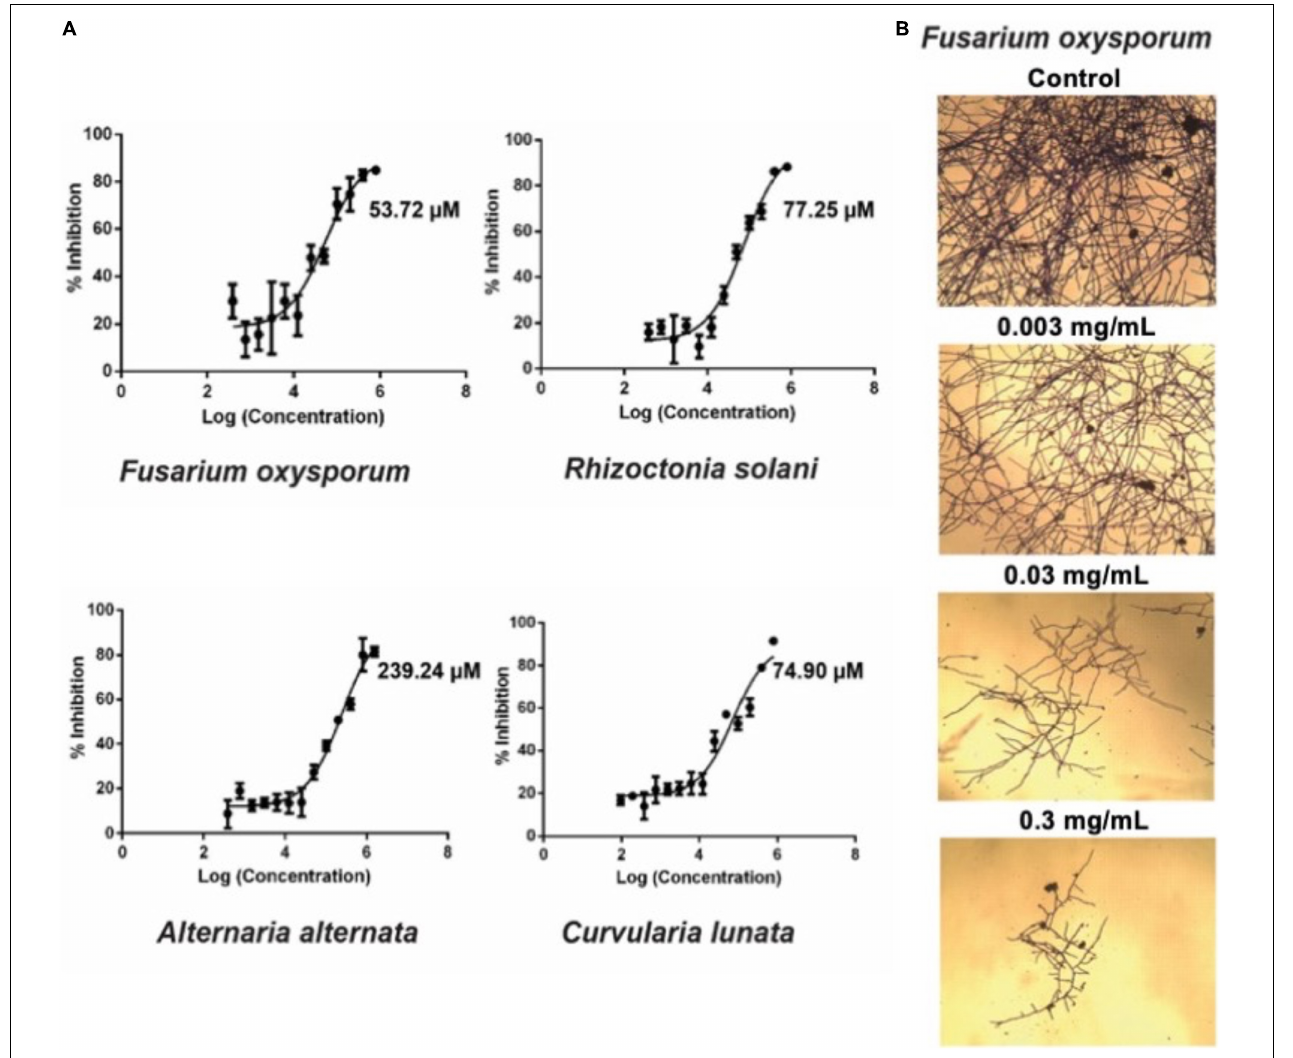
FIGURE 6 | Antifungal assays of avenatide aV1. (A) Fungal inhibition of avenatide aV1 against Fusarium oxysporum , Rhizoctonia solani , Alternaria alternata , and Curvularia lunata . The IC 50 was calculated based on the dose-response curve obtained from the micro-broth dilution assay. (B) Bright field microscopy of hyphal growth inhibition with avenatide aV1. F. oxysporum treated with different concentrations of avenatide aV1. Formation of stunted hyphae ends indicated that avenatide aV1 inhibits hyphal growth at the ends of the fungal mycelia.